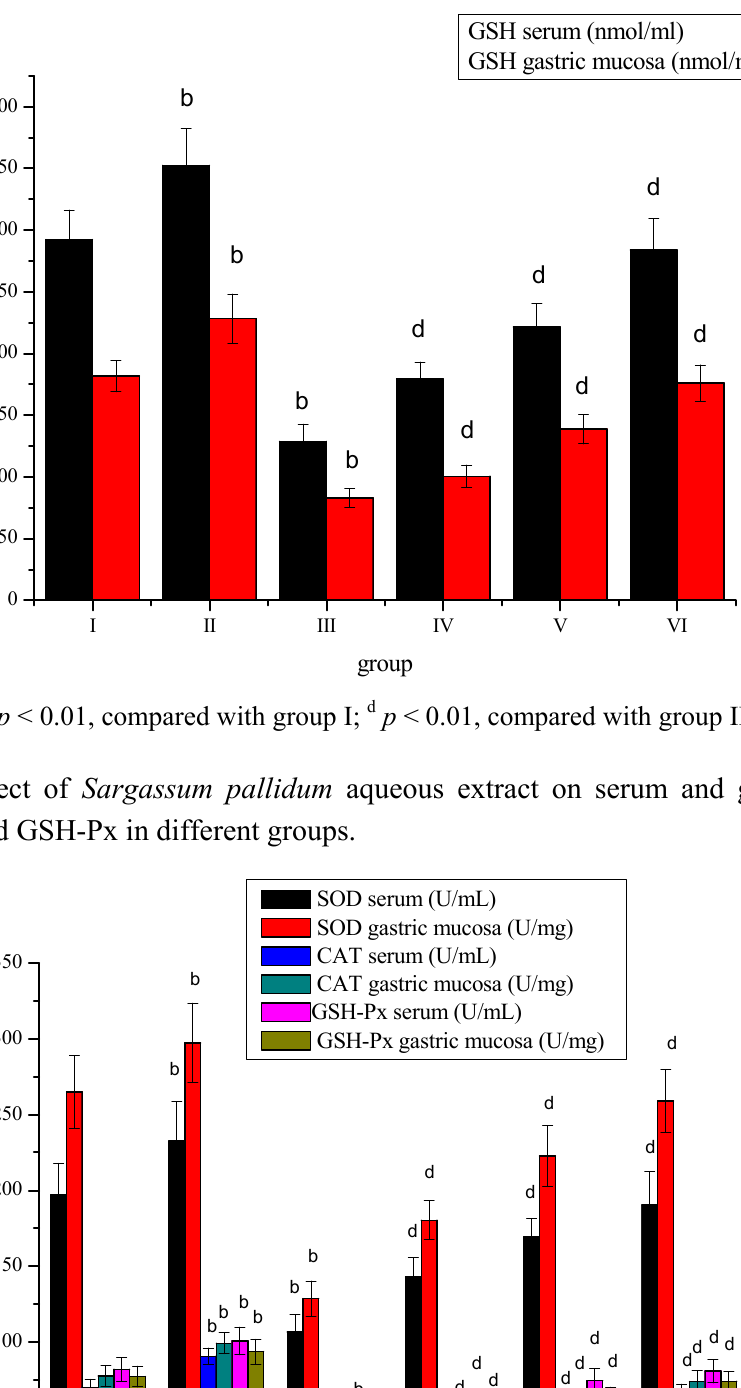
Figure 4. Effect of Sargassum pallidum aqueous extract on serum and gastric mucosa GSH level in different groups.